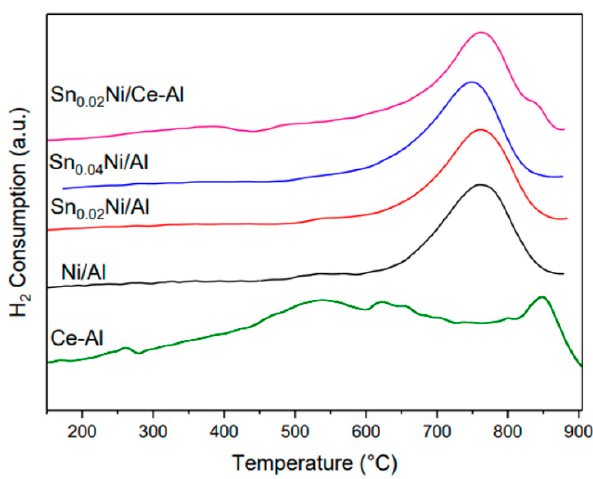
Figure 3. H 2 -TPR profiles of each catalyst. Reprinted with permission from [83]. Copyright Elsevier,